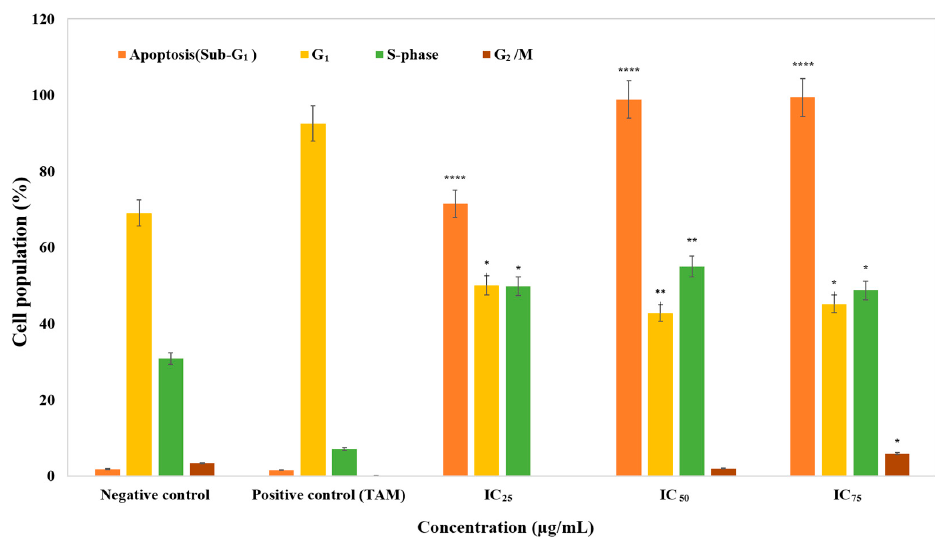
Figure 2. The cell cycles of MCF-7 cells treated with ZnO NPs. Cell populations are presented for each phase of the cell cycle for negative control (untreated cell), positive control (tamoxifen), and cells exposed to different concentrations of ZnO NPs for 24 h. Data represent the mean ± standard deviation (SD) ( n = 3). More information in shown in Appendix A. * p ≤ 0.0.5; ** p ≤ 0.0; *** p ≤ 0.001; **** p ≤ 0.0001. TAM: Tamoxifen.